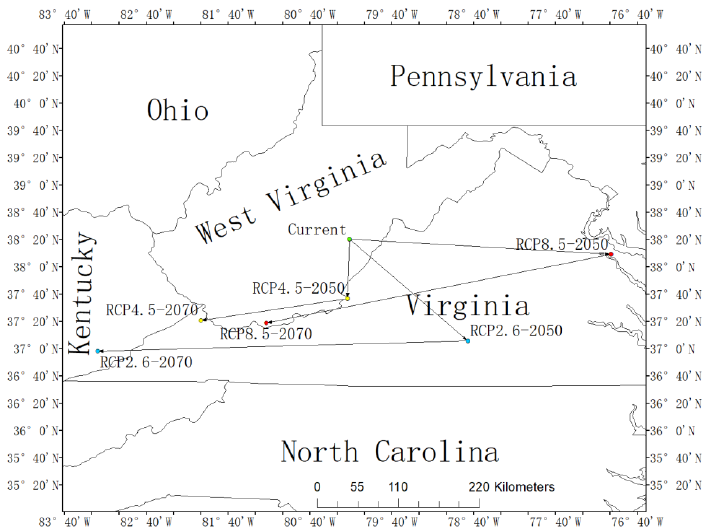
Figure 5. The core distributional shifts of Liriodendron tulipifera under different climate scenarios in USA.